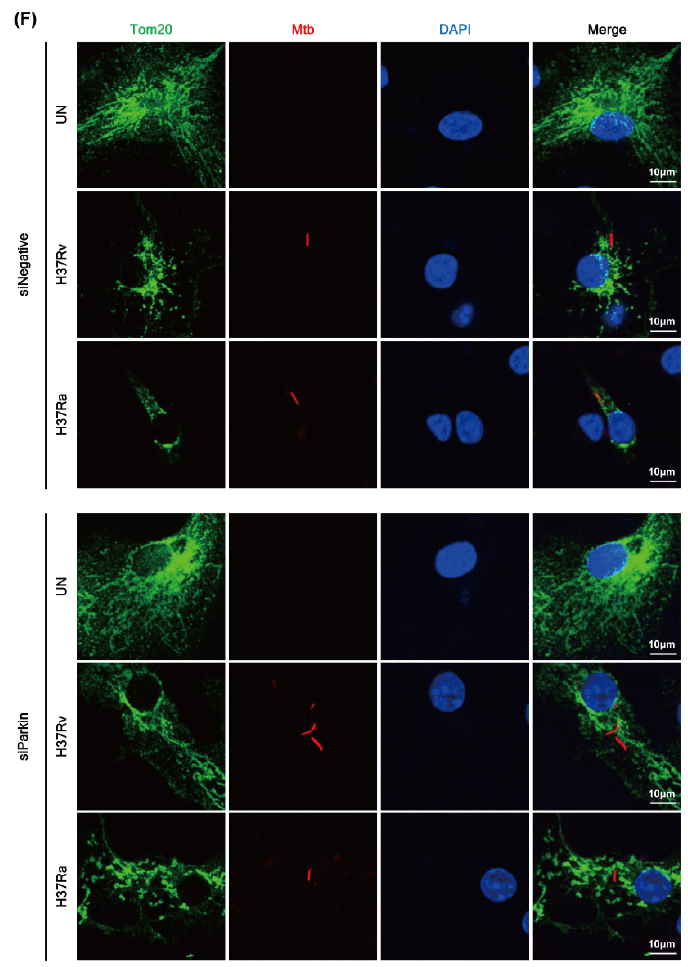
Figure 3. Mtb infection decreases mitofusin 2 (MFN2) production via Parkin induction. ( A , B ) Raw264.7 cells or BMDMs were infected with Rv or Ra (MOI = 1) for 3 h. After washing, the cells were incubated for 24 and 48 h. MFN2 and Parkin were detected by western blotting. ( C ) Representative confocal images of Mtb-infected cells. DNA was stained with DAPI (blue) and MFN2 (green). BMDMs were transfected with siNegative (200 nM) or siParkin (200 nM), and infected with Rv or Ra (MOI = 1; 48 h). In siRNA-transfected BMDMs, we measured the ( D , E ) expression of MFN2 and Parkin using western blotting, and ( F ) mitochondrial fragmentation by confocal microscopy. Data are representative of three independent experiments. Statistically significant di ff erences are indicated; ** p < 0.01, and *** p <